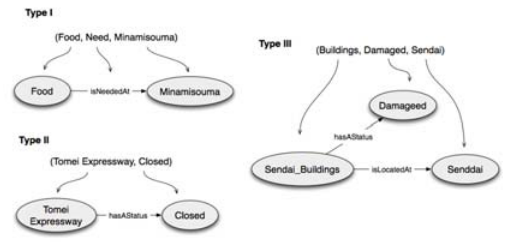
Figure 4. A triplified process from triple-like structures to RDF triples